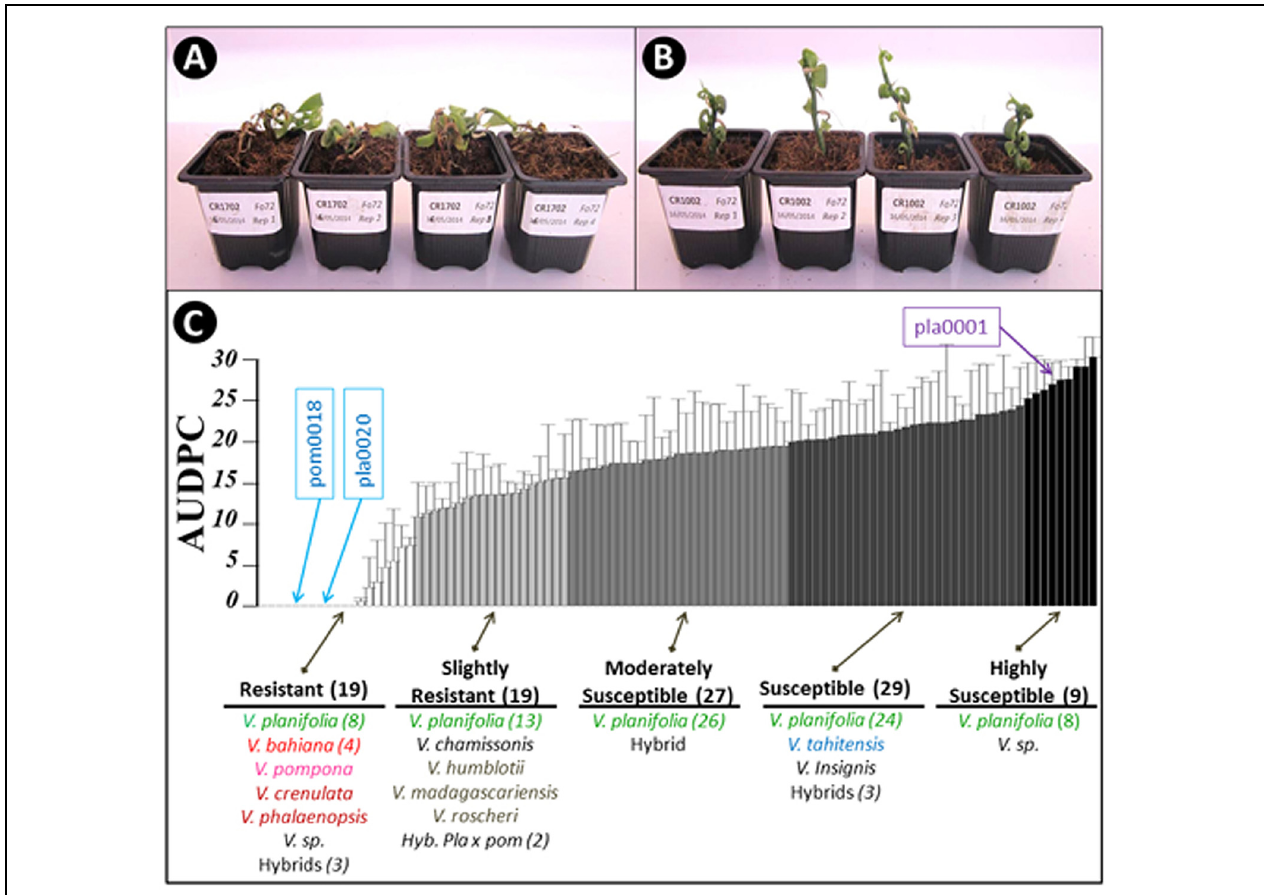
FIGURE 2 | Assessment of 103 Vanilla accessions for Fo72 resistance by in vitro plantlet assay. (A,B) Appearance of susceptible and resistant genotypes, respectively, 15 dpi. (C) The 103 accessions were split into five classes according to average AUDPC values (4 plants per accession). The whiskers indicate the upper bound of asymptotic 95% confidence intervals of the average AUDPC values. The number in brackets indicates the number of accessions in each group or species, when greater than 1. The position of the three accessions selected for the histopathological studies (pla0001, pla0020, and pom0018) are highlighted. TABLE 3 | Resistance to Fo72 of 52 V. planifolia selfed-progenies obtained from different accessions of ordinary V. planifolia susceptible to Forv . Resistance group 1 Parent pla0035 pla0040 pla0041 pla0051 pla0066